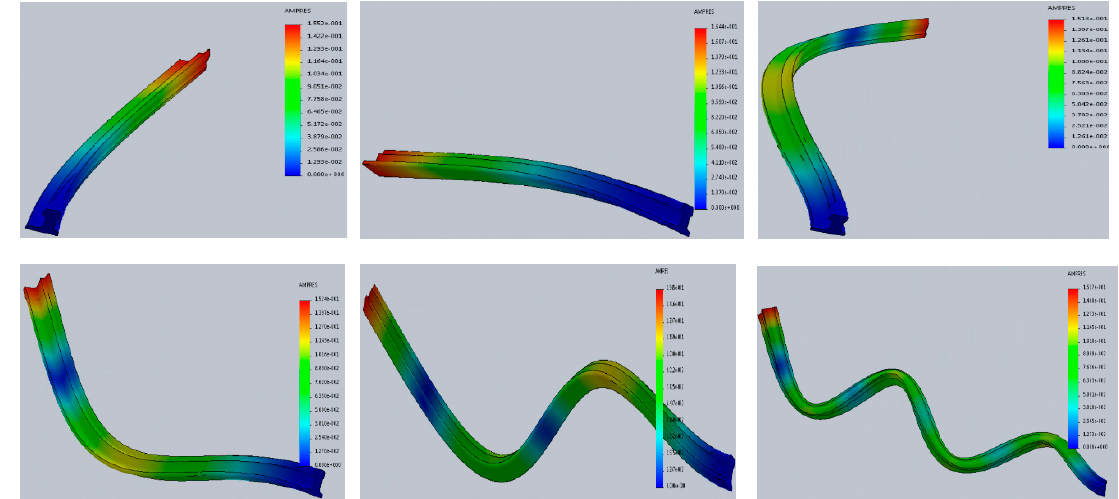
Figure 9. Mode vibrations of the beam with a variable cross-section (from the first natural frequency to the sixth—from the left side).